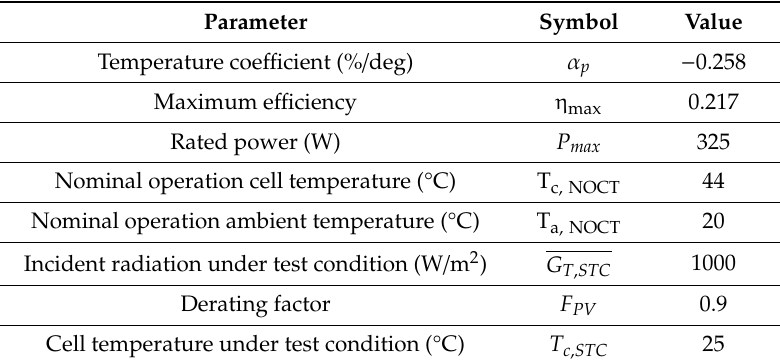
Table 2. Main input data used in the PV output power estimation